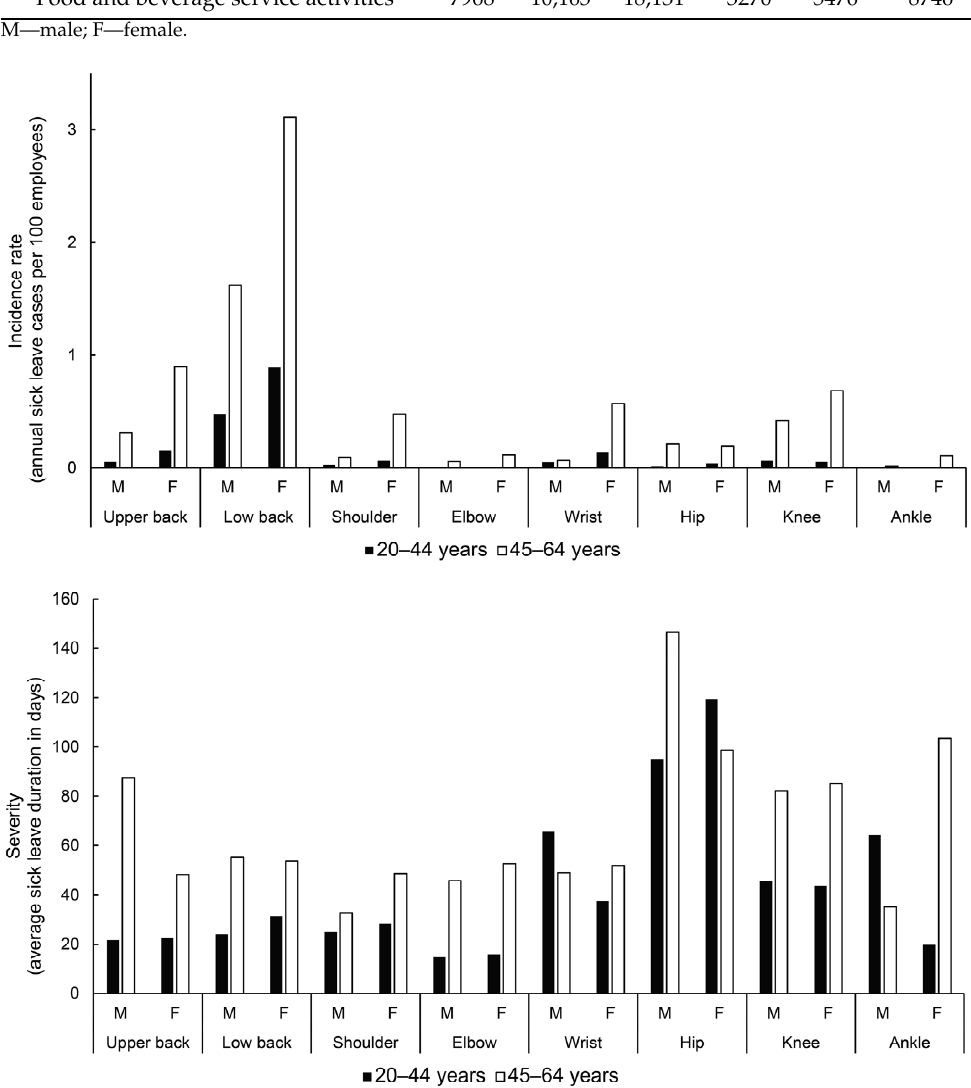
Figure 1. Average sick leave determinants due to work-related musculoskeletal disorders (2015–2019) in sector I by age group, gender and body region. M—male; F—female.